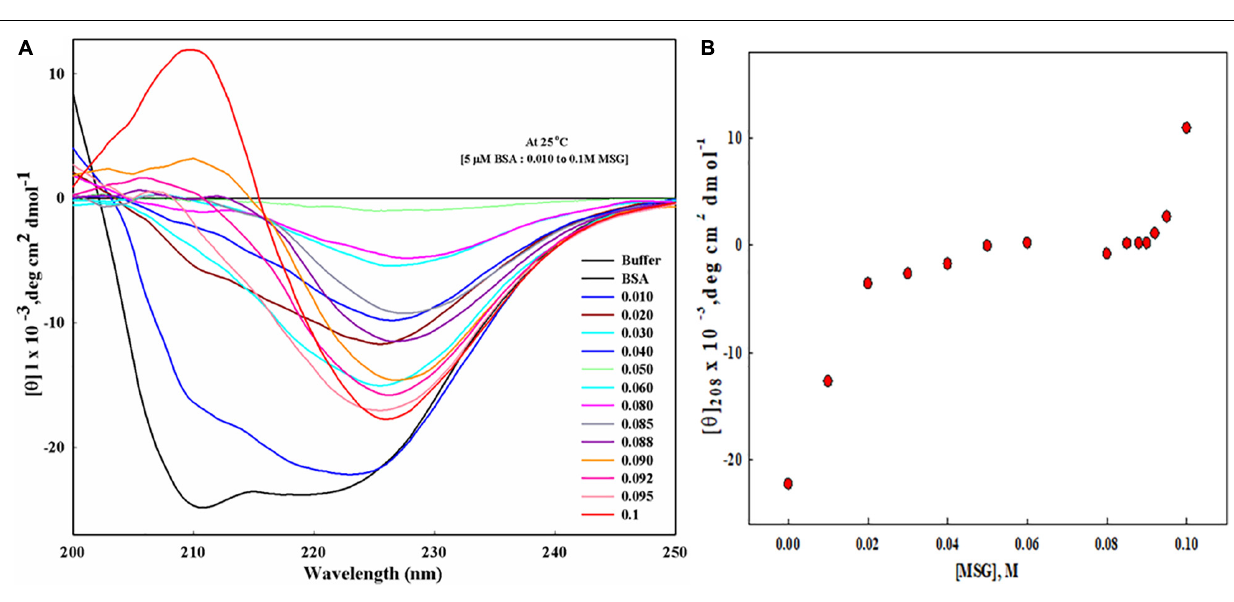
FIGURE 7 | (A) Far UV-CD spectra of BSA in presence of increasing concentration (from 0.01 M to 0.1 Molar) MSG at 25 ◦ C, 25 mM phosphate buffer, and pH. 7.0. (B) The plot of mean residual ellipticity of BSA at 208 nm versus the concentration of